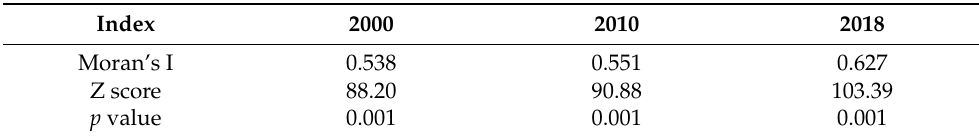
Table 2. Global Moran’s I statistic of the remote sensing ecological vulnerability index on the Qing- hai-Tibet Plateau in 2000, 2010, and 2018.